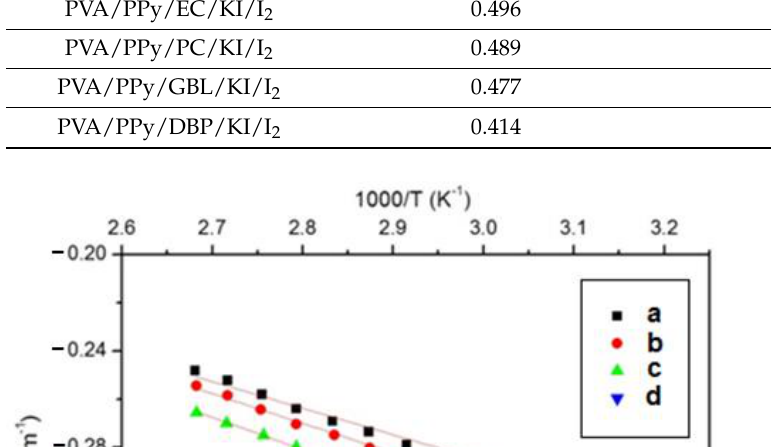
Figure 6. Plots of log σ versus 1000/ T for the PVA/PPy/KI/I 2 electrolyte with various plasticizers (in wt%); ( a ) EC, ( b ) PC, ( c ) GBL, and ( d ) DBP.